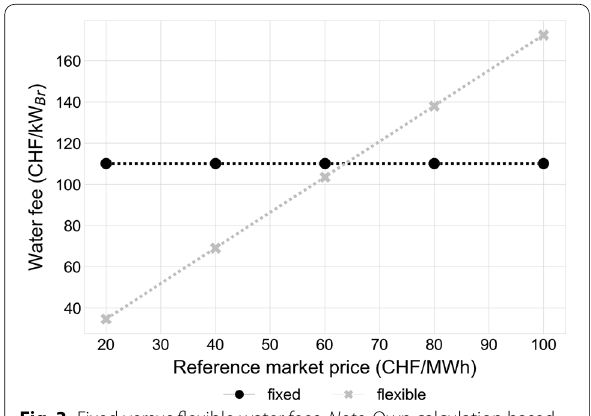
Fig. 3 Fixed versus flexible water fees. Note: Own calculation based on Swiss Federal Council (2017) and SFOE (2018a,